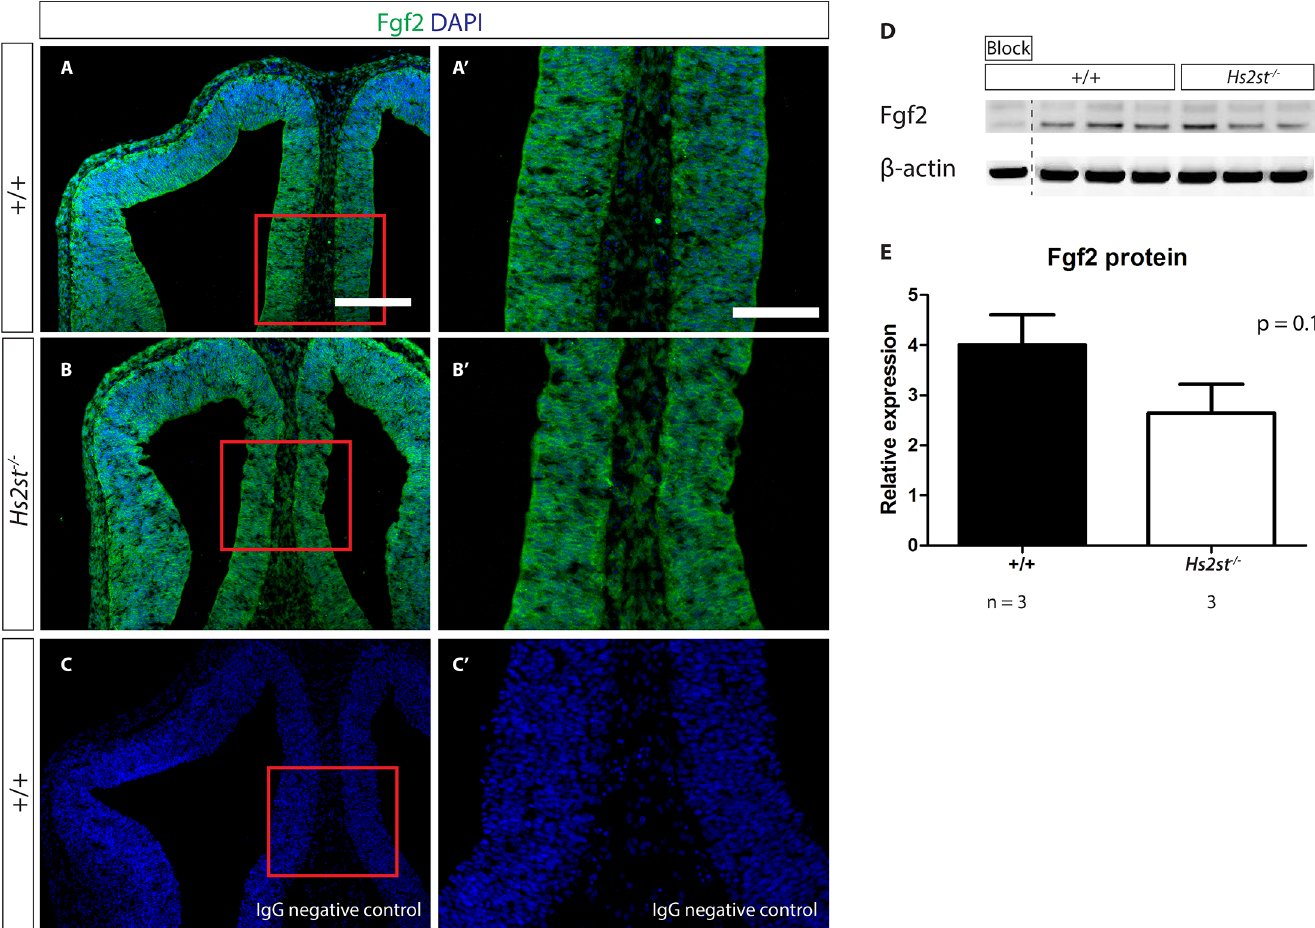
Fig 3. 2-O HS sulfation does not affect Fgf2 protein level or distribution at the E12.5 telencephalic midline. ( A, B ) Immunohistochemistry detecting Fgf2 (green) in ( A ) wild-type or ( B ) Hs2st -/- telencephalic midline. ( C ) is the IgG negative control where primary antibody specific for Fgf2 was omitted. Nuclei labelled with DAPI (blue). ( A ’ - C ’ ) are higher magnification of red boxes in ( A - C ). ( D ) Western blot of protein extracted from E12.5 wild-type and Hs2st -/- telencephalon reacted simultaneously with Fgf2 and β -actin antibodies. Fgf2 antibody specificity demonstrated using Fgf2-specific blocking peptide (lane labelled as block). Dotted lines indicate re-arranged lanes from the same blot. ( E ) Histogram of Fgf2 protein levels in wild-type and Hs2st -/- telencephalon quantified from blot in ( D ) indicating lack of significant difference between wild-type and Hs2st -/- samples. Statistical analysis was done using Student ’ s T- test. Scale bars for ( A – C ) are represented in ( A) where it is 250 μ m ( A ’ – C ’ ) are represented in ( A ’ ) where it is 150 μ